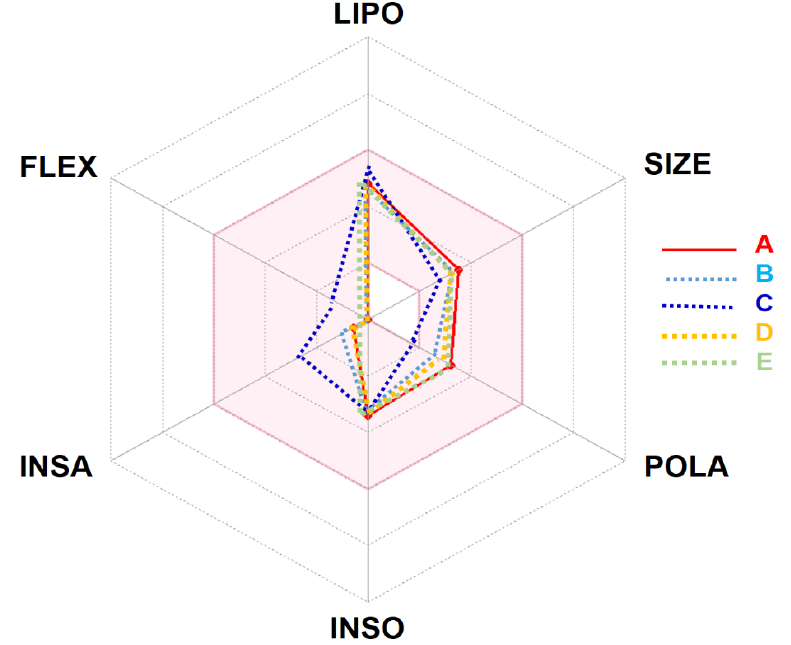
Figure 1. Bioavailability radar of Artemisia campestris selected compounds (A: artemisinin, B: acetate of dihydroartemisinin, C: artemisinic aldehyde, D: deoxyartemisinin, and E: dihydroartemisinin) based on physicochemical indices ideal for oral bioavailability. LIPO, Lipophilicity: − 0.7 < XLOGP3 < þ 5; SIZE, Molecular size: 150 g/mol < mol. wt. < 500 g/mol; POLA, Polarity: 20 Å2 < TPSA <130 Å2; INSO, Insolubility: 0 < Log S (ESOL) < 6; INSA, Insaturation: 0.25 < Fraction Csp3 < 1; FLEX, Flexibility: 0 < Number of rotatable bonds < 9. The colored zone is the suitable physicochemical space for oral bioavailability. Note: the selected compounds stand in the pink area, which indicates the ideal and suitable compounds’ bioavailability.